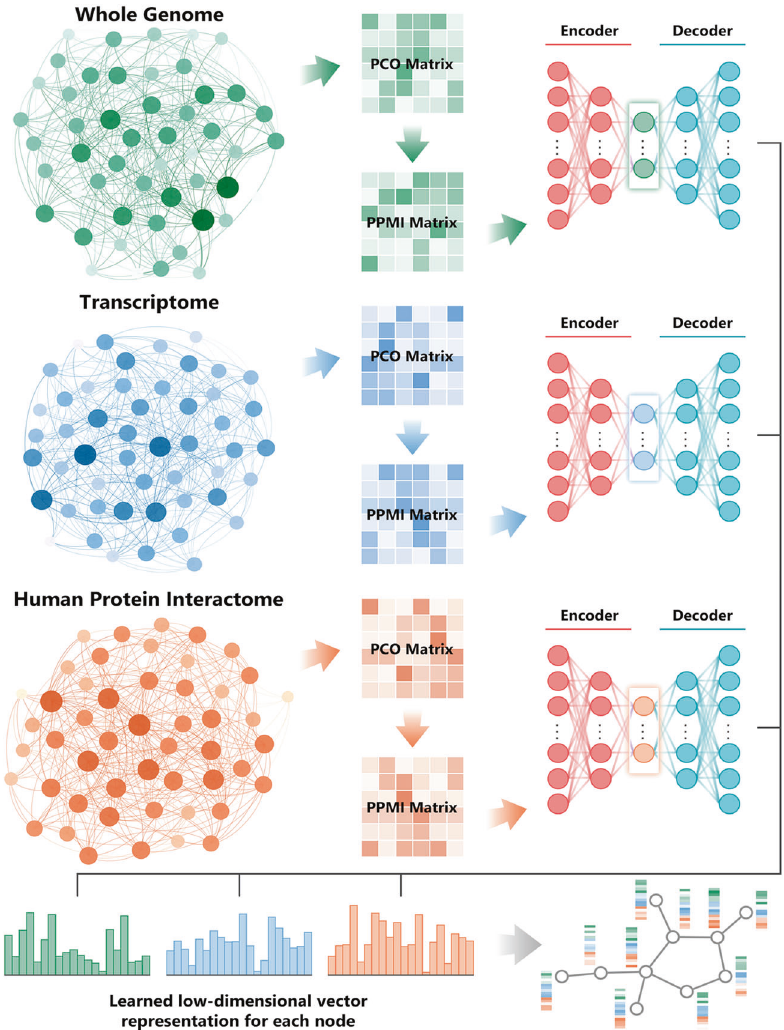
Fig. 1 A work fl ow illustrating an arti fi cial intelligence-based, exascale computing framework for integrative analysis of multi-omics data for precision cancer medicine. PCO, probabilistic co-occurrence; PPMI, positive pointwise mutual information. The detailed description about a deep neural network-based multi-omics and network integration can be found in a recent study 81 function. Under physiological conditions, crosstalk enables cells to cope with perturbations of homeostasis. In drug resistance, inhibition of a signaling pathway can promote activation of a survival pathway that bypasses the inhibited pathway. Insight into connections between signaling pathways and foresight into their distinct activation can be powerful in the treatment of cancer. 22 What distinguishes proliferation pathways from other signaling pathways? The Ras/phosphoinositide 3-kinase (PI3K)/Akt and Ras/extracellular signal-regulated kinase (ERK) pathways provide good examples of proliferation pathways. 23,24 Ras is activated by stimulated receptor tyrosine kinases (RTKs). Ras mutants are involved in roughly a third of the cancers. The identity of the other two-third proliferation pathways is only partially known. Proliferation involves cell growth and division. Proliferation can take place through many pathways and is particularly active during development. It is also essential in adult homeostasis. Signaling pathways that control cell proliferation 25 can act by linking the cellular environment to progression through the G1 (Gap 1) phase of the cell cycle (Fig. 2). Progression through G1 is controlled